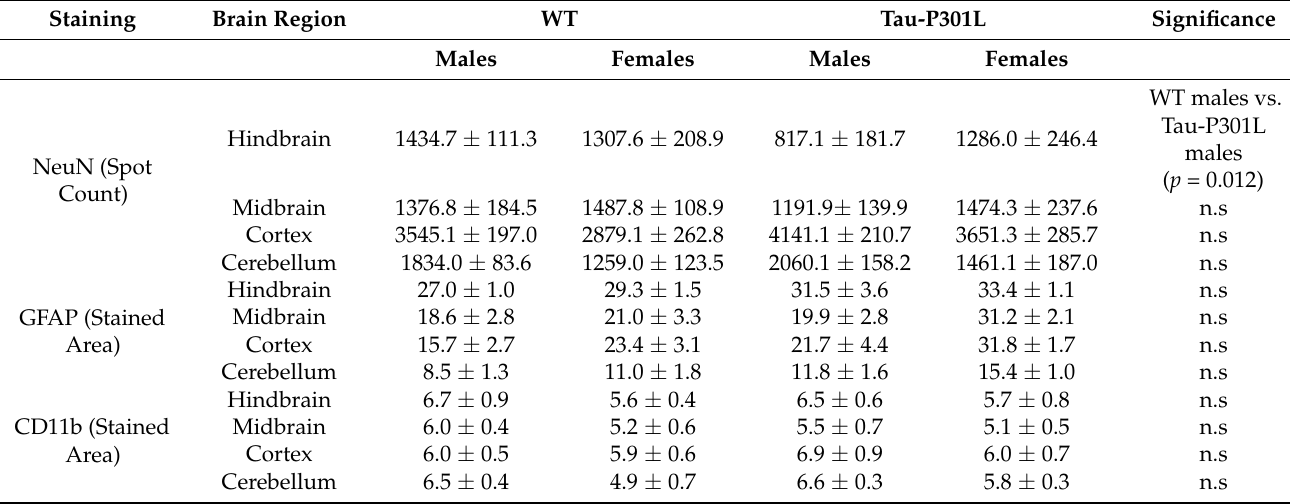
Table 3. Neuronal loss and gliosis in Tau-P301L mice in different brain